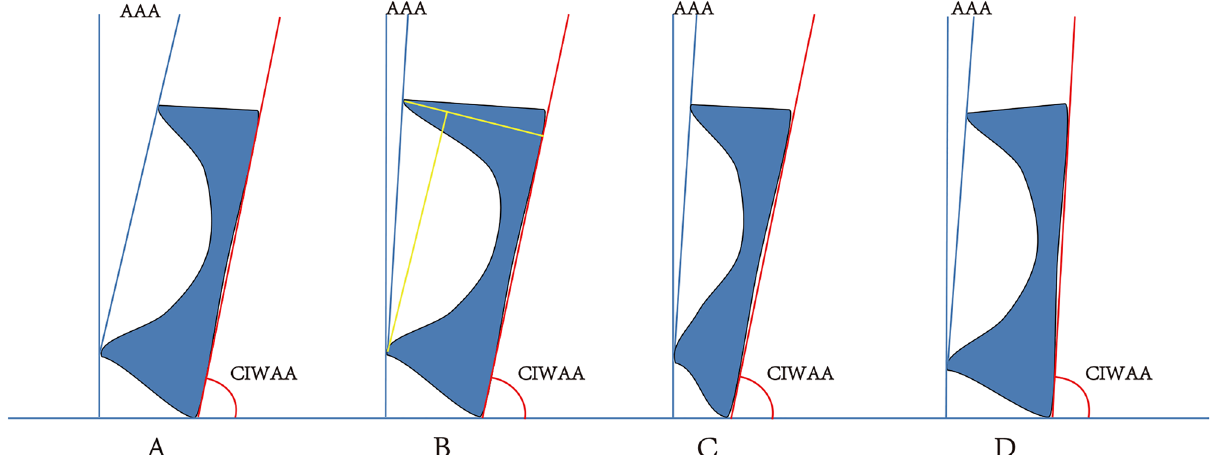
Figure 7. Schematic diagram of different types of acetabulum retroversion. ( A ) Normal acetabulum; ( B ) Protrusion of anterior wall and normal posterior wall; ( C ) Normal anterior wall and dysplasia of posterior wall; ( D ) Normal anterior and posterior wall and retroversion of hemipelvis. AAA is acetabulum anteversion; CIWAA is complement angle of pelvis anteversion (CIWAA = 90-IWAA). (Adobe Illustrator Cs6, Version 16.0.0, URL: https:// www. adobe. com/ cn/ produ cts/ illus trator.